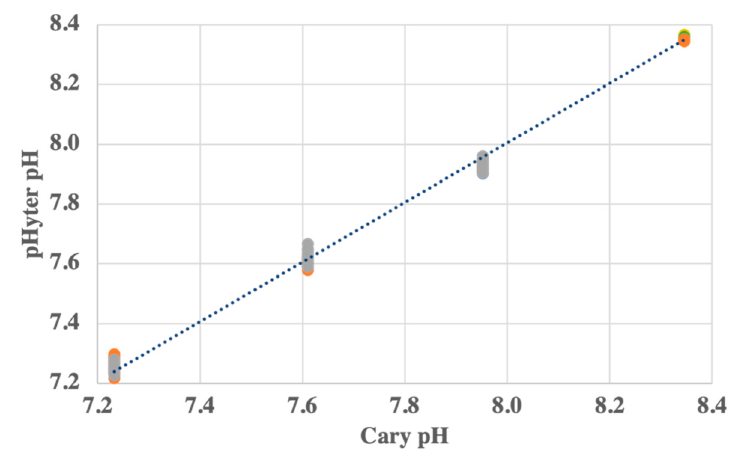
Figure 3. (pHyter versus Cary seawater pH measurements). Seawater pH measurements made by pHyters in relation to Cary UV-Vis measurements at four pH values between 7.2 and 8.3. The slope of the linear fit is 0.997, R 2 = 0.998, n = 69). Six pHyters were used, shown in yellow, turquoise, green, blue, orange, and gray.